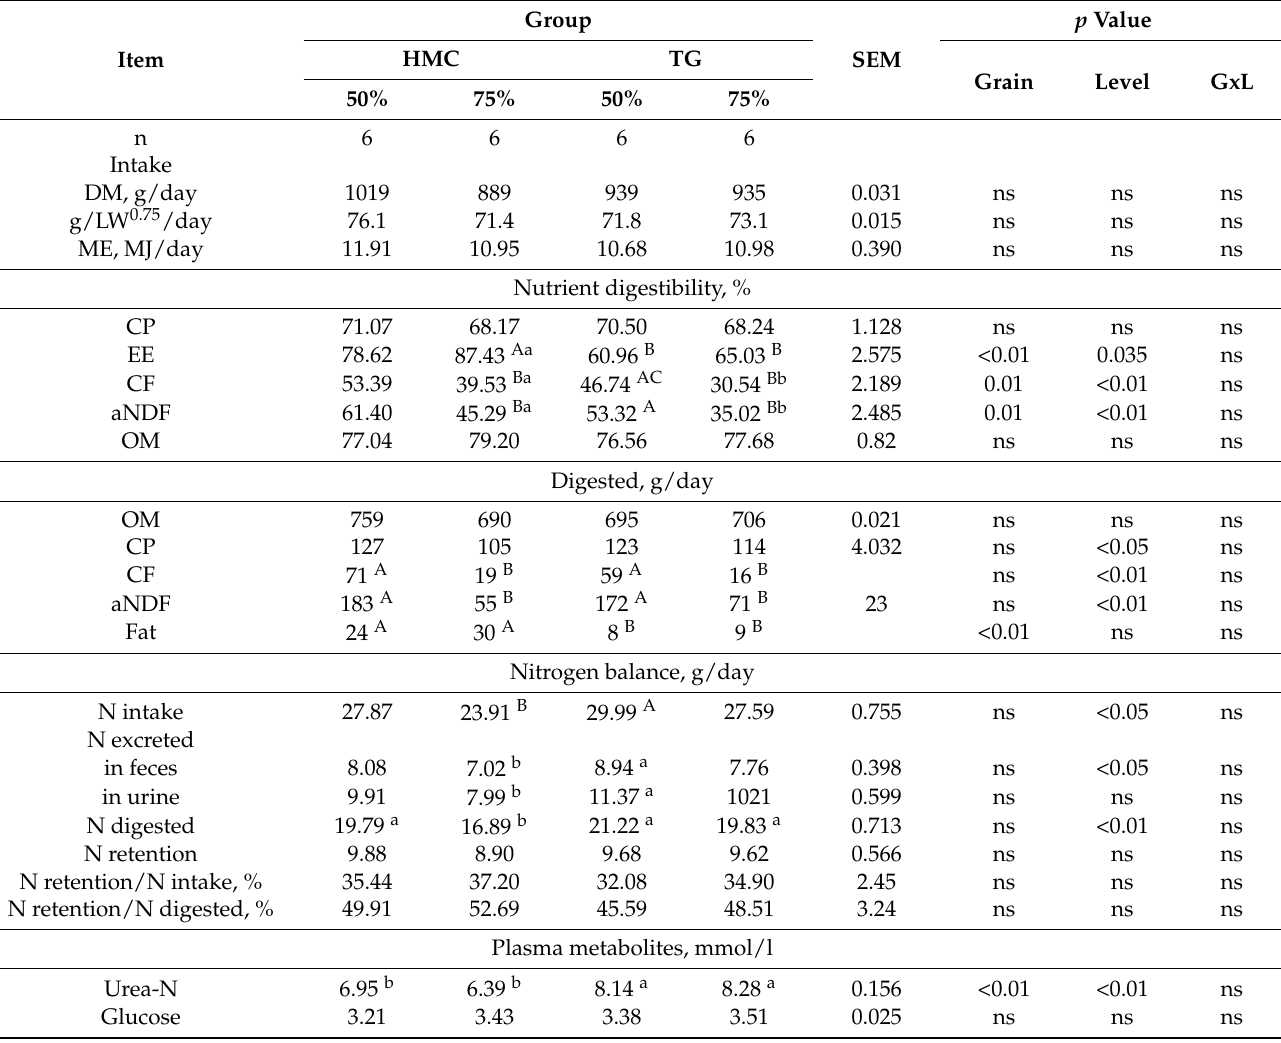
Table 3. Nutrient intake and digestibility, nitrogen balance, and serum urea and glucose levels in